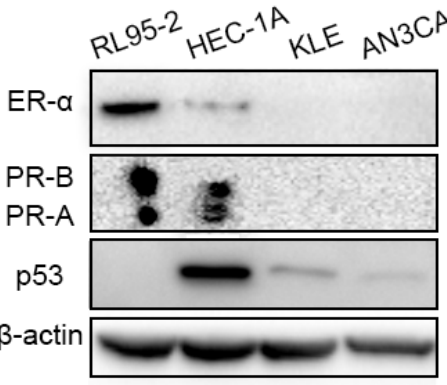
Figure 1. Expression of estrogen receptor-α (ER-α), progesterone receptor (PR), and p53 in RL95-2, HEC-1A, and KLE cells. Int. J. Mol. Sci. 2019 , 20 , x FOR PEER REVIEW 4 of 15